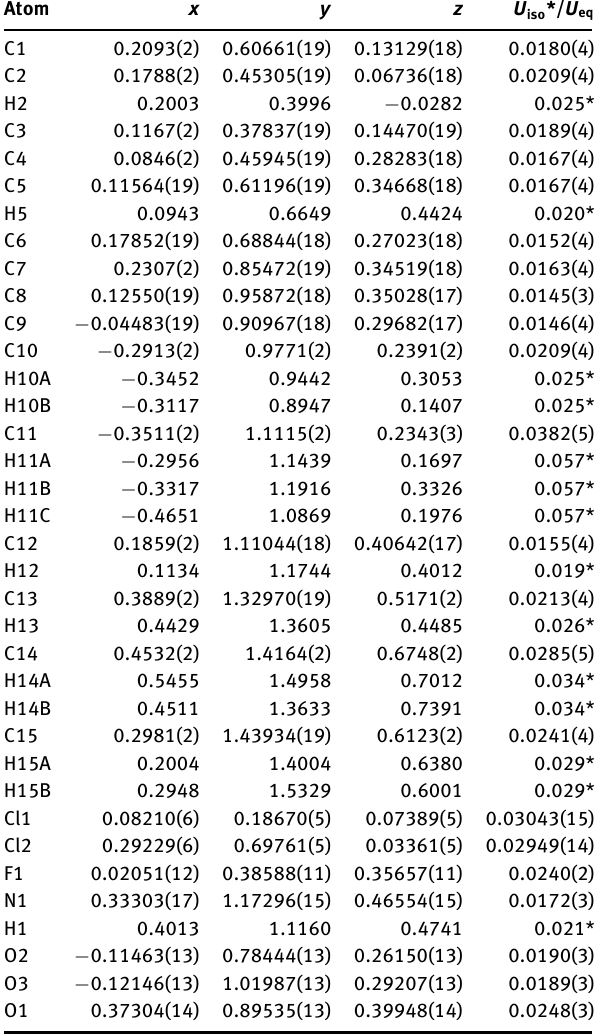
Table 2: Fractional atomic coordinates and isotropic or equivalent isotropic displacement parameters (Å 2